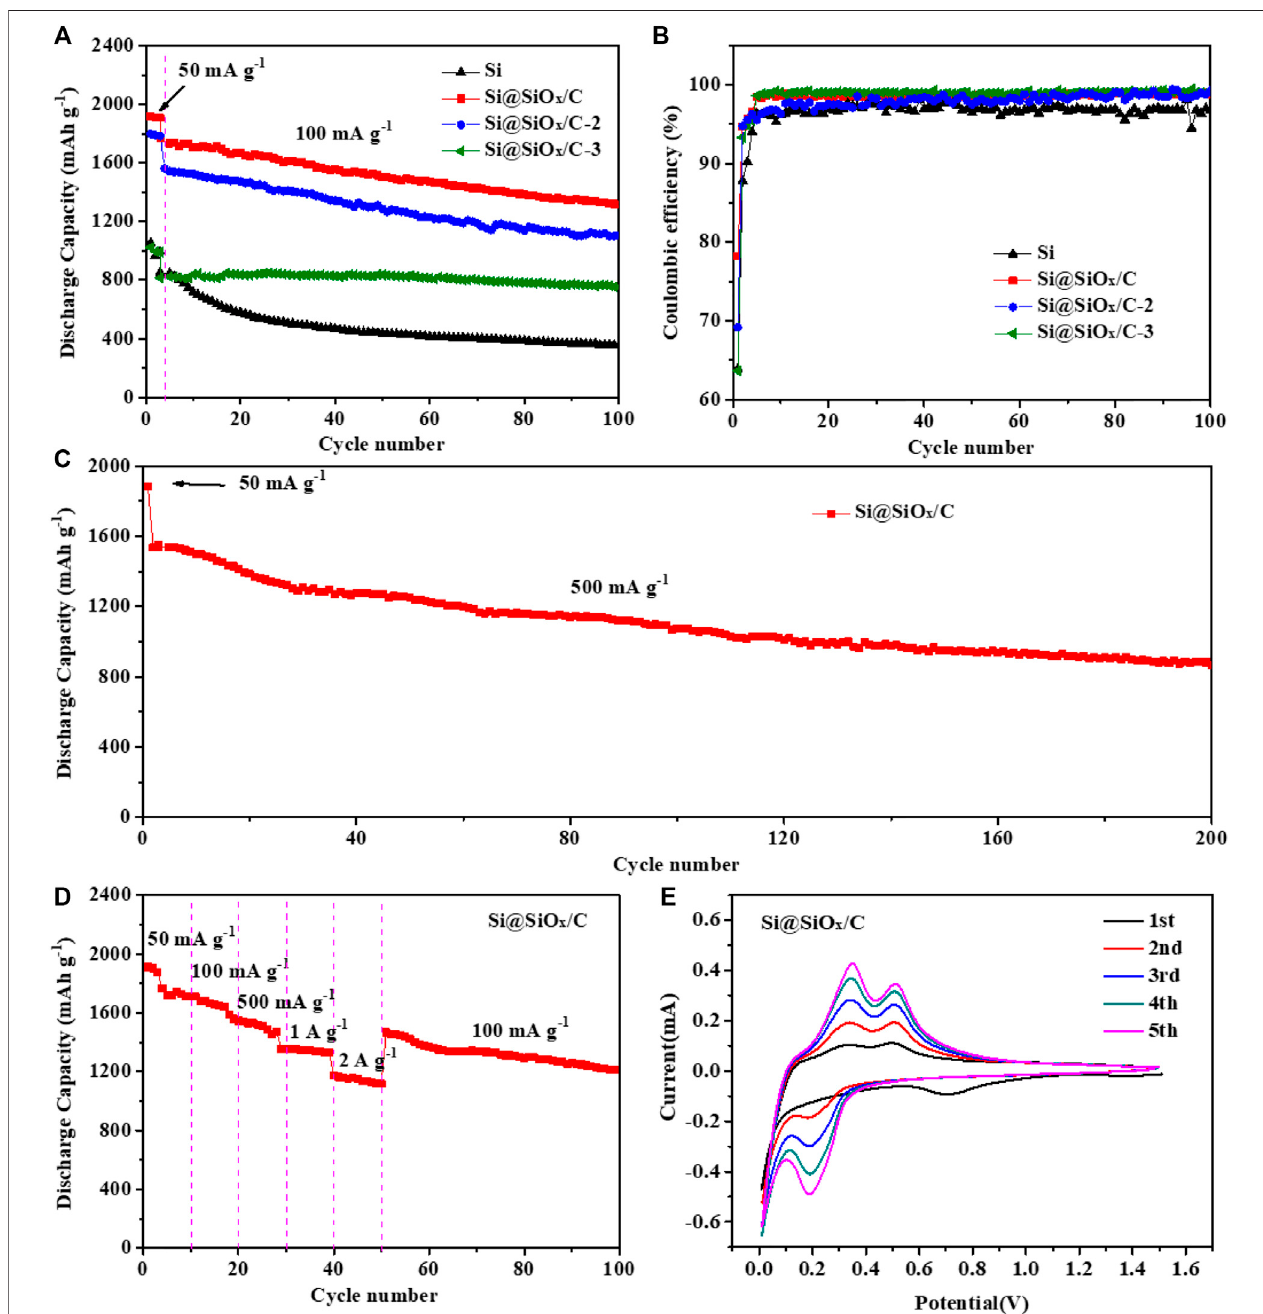
FIGURE 4 | (A) Cycle performance curves and (B) corresponding Coulombic ef fi ciency curves of Si, Si@SiO x /C, Si@SiO x /C-2 and Si@SiO x /C-3 anodes between 0.01 and 1.5 V at 100 mA g − 1 . (C) Cycle performance curves Si@SiO x /C anode at 500 mA g − 1 . (D) Rate performance curve of Si@SiO x /C anode and (E) CV curves of Si@SiO x /C anode from the 1st to 5th cycle at a scan rate of 0.1 mV s − 1